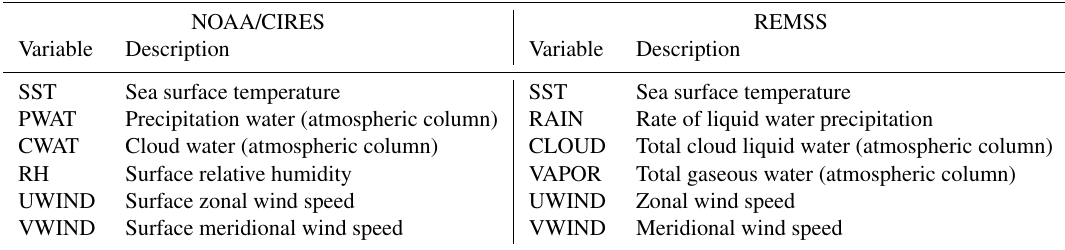
Table 1. Multi-physical variables in the corresponding two